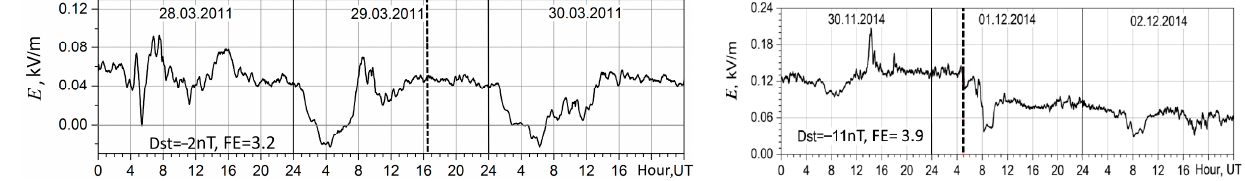
Figure 6. Values of the atmospheric electric field after the CMEs 29 March 2011 and 1 December 2014. The vertical solid line indicates the boundaries of the day, the dashed vertical line indicates the beginning of the FE.